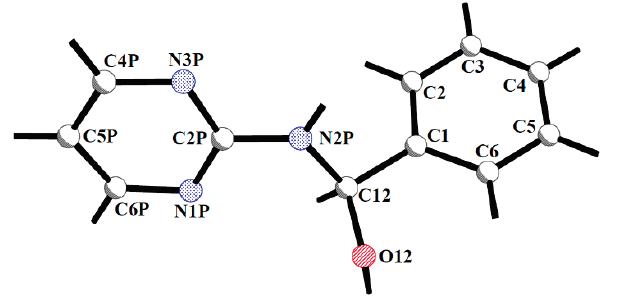
Figure 2. General numbering scheme for hemiaminals with pyrimidine ring.